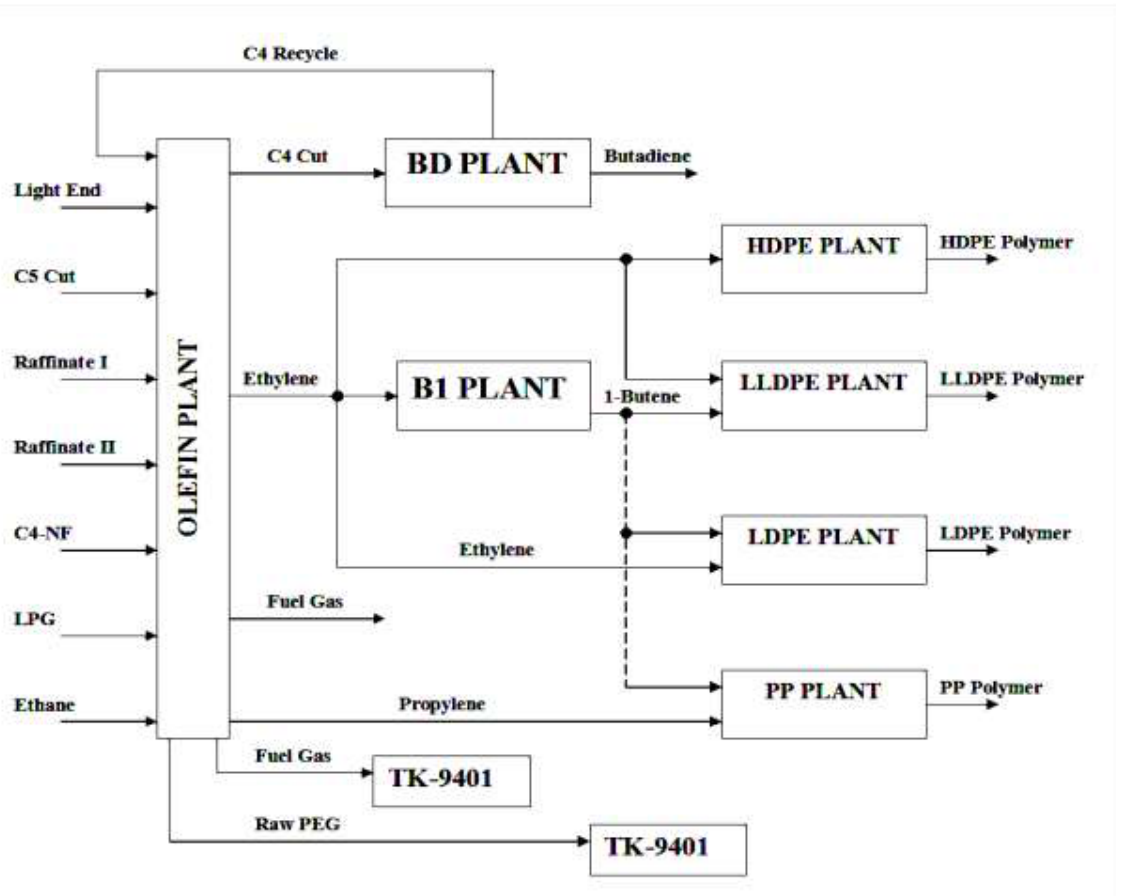
Figure 2: Brief process diagram of Amirkabir petrochemical